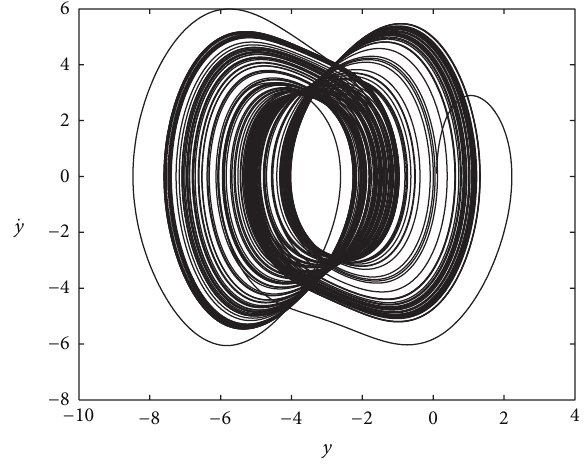
Figure 2: Phase plane trajectory of system